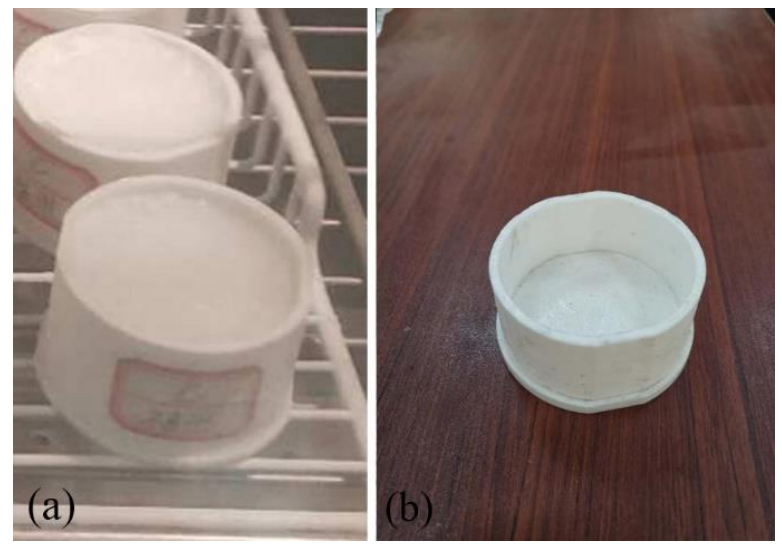
Figure 16. Ice mold for Brazilian disc splitting test. ( a ) Ice sample were frozen and shaped in the ice mold. ( b ) Ice mold.